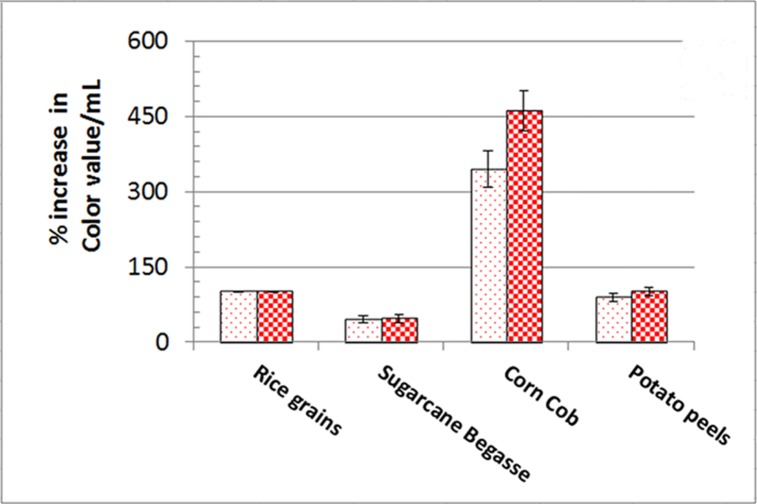
Effect of carbon source on orange and red monascus production.Dotted bars: orange moanscus pigments. Checkboard bars: red monascus pigments.